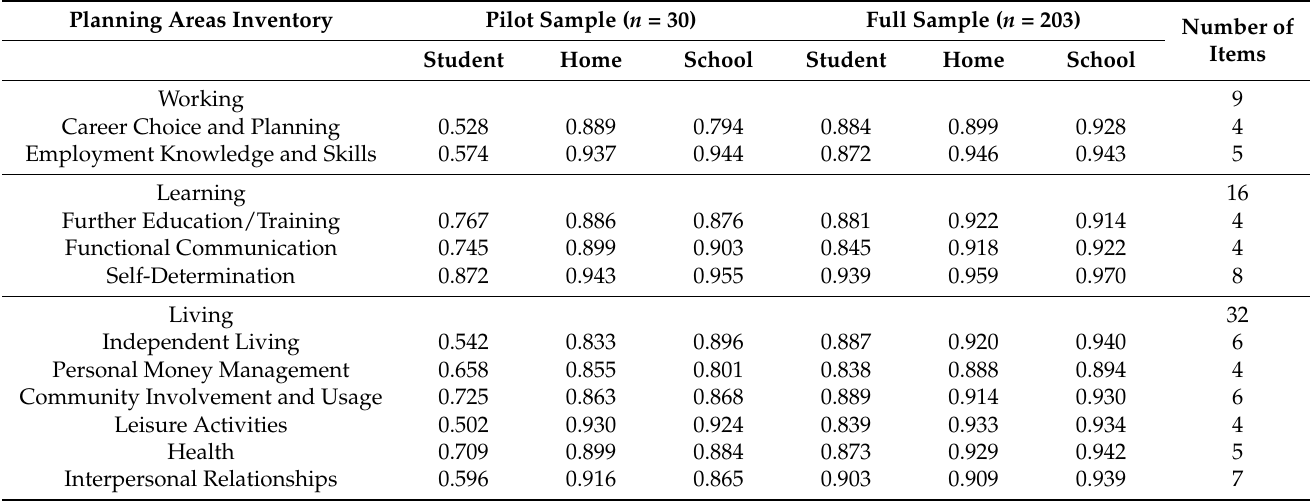
Table 2. Cronbach’s alpha for all